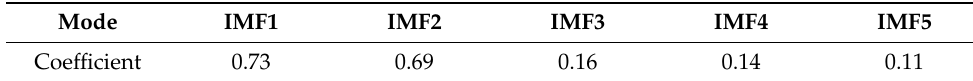
Table 4. Coefficients under IEMD decomposition.